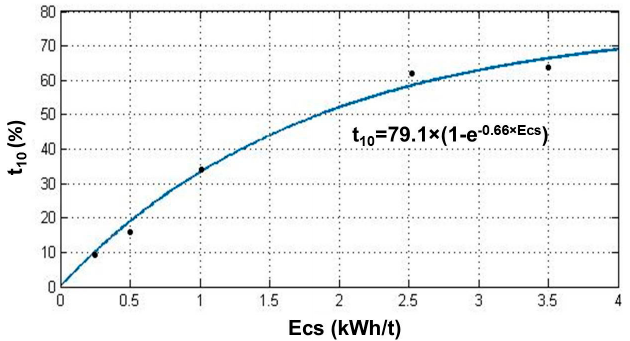
Figure 3. Fitted t 10 – E cs curve for the SMC tests.